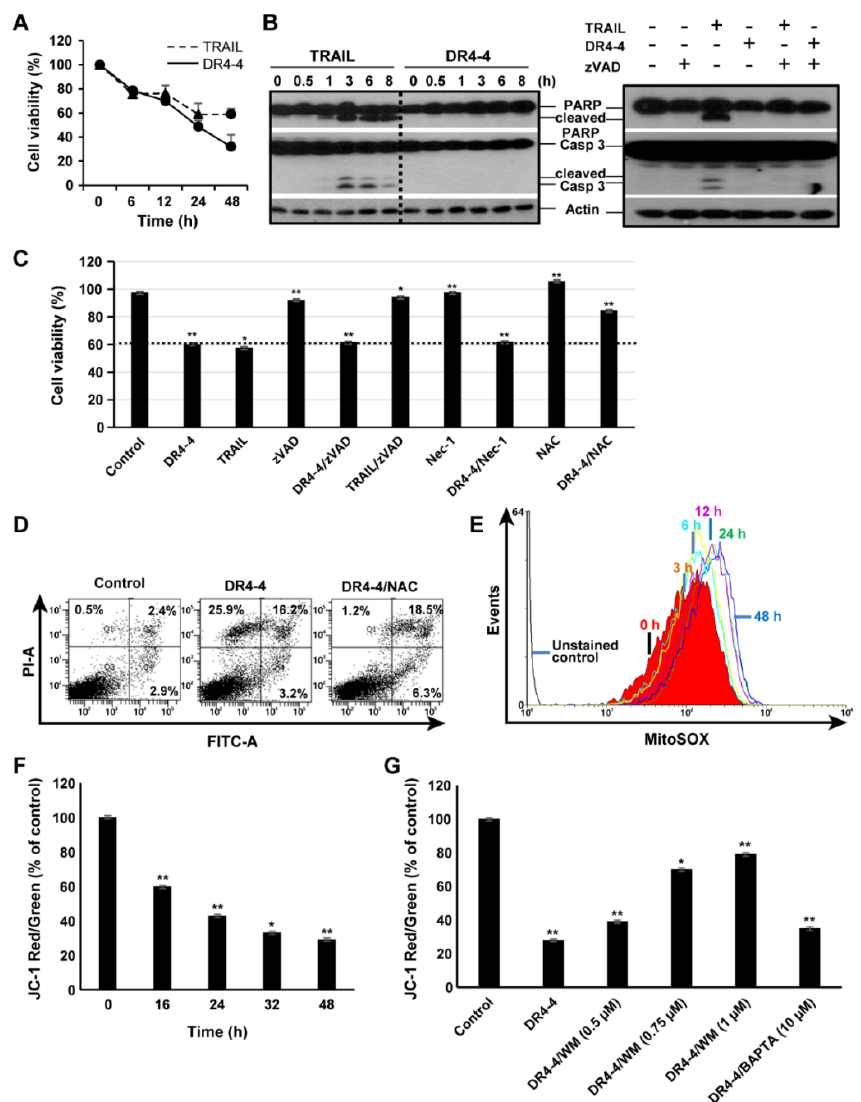
Figure 4. Caspase-independent and mitochondrial-induced cytotoxicity of DR4-4 Fab. ( A ) Jurkat cells (2.5 × 10 4 ) were treated with TRAIL (125 ng/mL) or DR4-4 Fab (100 µg/mL) for the indicated time and cell viability was measured by MTT assay. ( B ) Cells (1 × 10 6 ) were treated with TRAIL (125 ng/mL) or DR4-4 Fab (100 µg/mL) for the indicated time with or without a 3 h pretreatment with z-VAD (20 µM). Caspase-3, cleaved caspase-3, poly(ADP-ribose) polymerase (PARP), and cleaved PARP were detected by immunoblotting with specific antibodies. β-actin was used as a control to quantify the relative amount of sample loaded in each well. ( C ) MTT assay after treatment of cells with DR4-4 Fab (30 min pretreatment with or without z-VAD (20 µM), Nec-1 (50 µM), and N -acetyl- L -cysteine (NAC; 5 mM)) or TRAIL (30 min pretreatment with or without z-VAD (20 µM)). ( D ) Cells were treated with DR4-4 Fab (100 µg/mL) for 6 h in the presence or absence of NAC (5 mM), stained with annexin V-FITC/PI, and analyzed by flow cytometry (1 × 10 6 cells were counted). ( E ) Mitochondrial reactive oxygen species generation was measured by flow cytometry after treatment with DR4-4 Fab (100 µg/mL) for the indicated time (0–48 h) and 5 µM MitoSOX staining. ( F ) Cells were treated with 100 µg/mL DR4-4 Fab (0, 16, 24, 32, and 48 h) and stained with JC-1 to analyze mitochondrial membrane potential (MMP). The ratio of red to green forms of JC-1 was measured by flow cytometry. ( G ) Cells were treated with 100 µg/mL DR4-4 Fab for 48 h with or without wortmannin (WM) and 1,2-bis( o -aminophenoxy)ethane- N,N,N ′ ,N ′-tetraacetic acid (BAPTA; 10 µM). After staining with JC-1, cells were analyzed by flow cytometry for MMP. Data presented as mean ± standard deviation (* p < 0.05, ** p < 0.005, versus control).